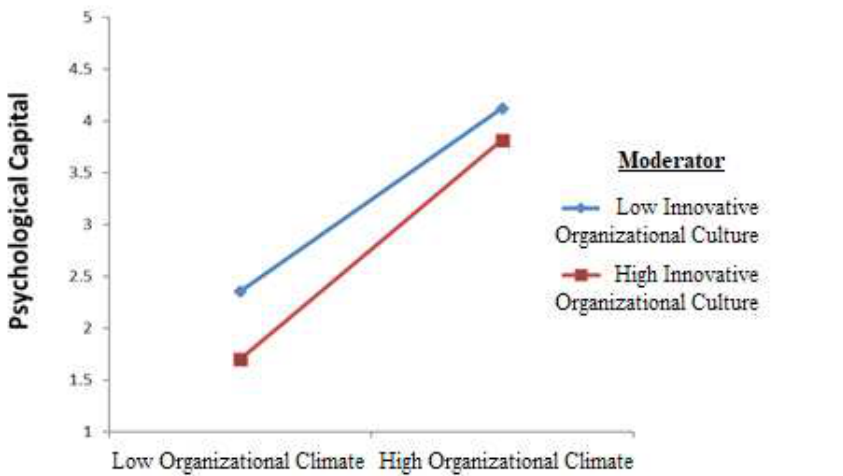
Figure 2. Relationships between the